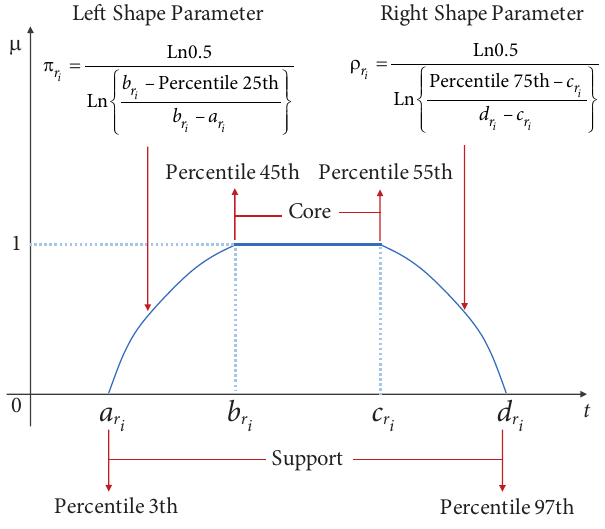
Figure 1. Parameters of the membership function of ξ ri by using the sample percentiles of the returns of the asset